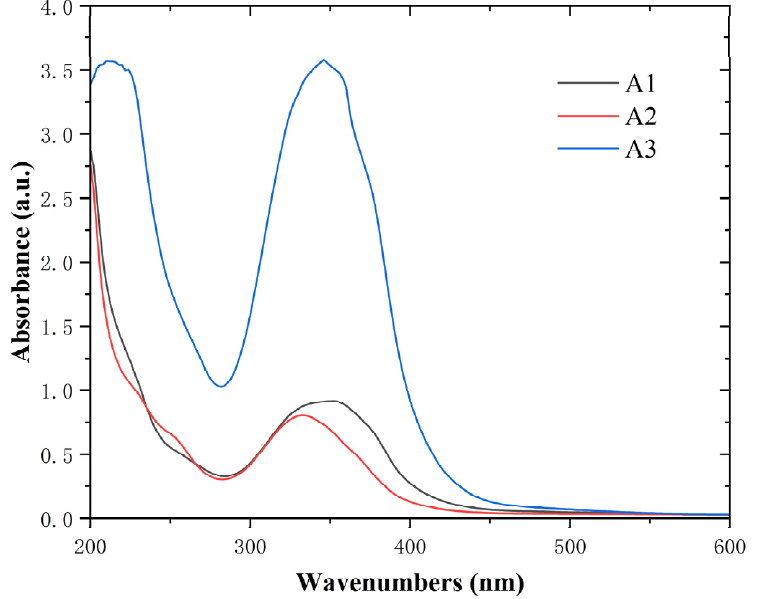
Figure 3. Experimental absorption spectra of A1 (black), A2 (red), and A3 (blue). The excitation wavelength and emission wavelength are essential parameters for fluorescence detection. Choosing the appropriate excitation and emission wavelengths is important for both sensitivity and selectivity of detection. The best excitation wavelength of T1 , T2 , T3 , and T4 is 273, 273, 327, and 272 nm, respectively, which corresponds to Figure 4a. The best emission wavelength of T1 , T2 , T3 , and T4 is 310, 315, 377, and 313 nm, respectively, which corresponds to Figure 4b.